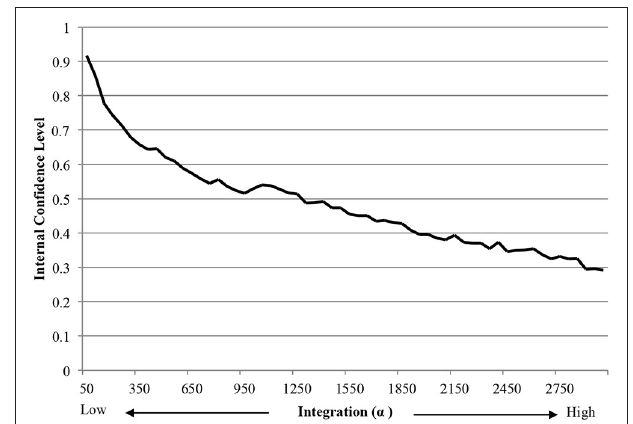
FIGURE 9 | Effect of integration on internal confidence level of simulated